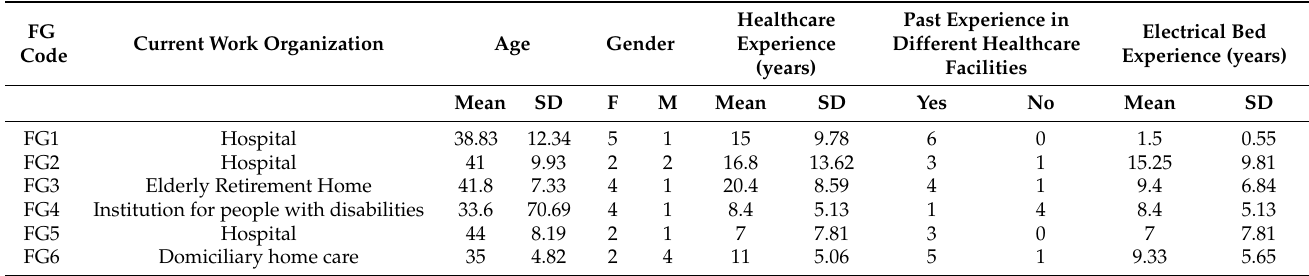
Table 1. Table describing the characteristics of the participants participating in the study. FG